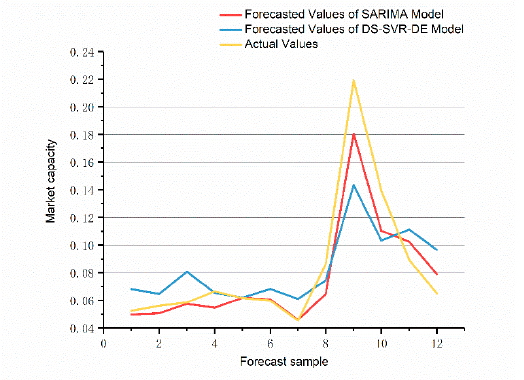
Figure 9. The short-term prediction performance of the proposed DS-SVR model and the SARIMA model in the medium-sized type.